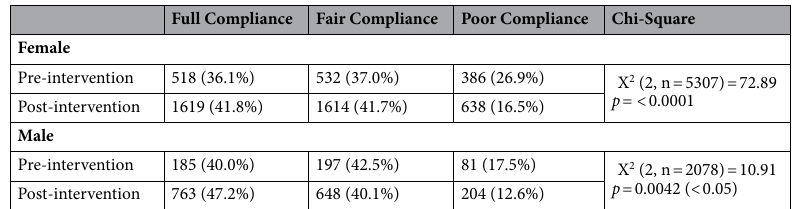
Table 3. Compliance within gender groups pre-and post-intervention. A Chi-square test was used to test for differences between intervention groups.